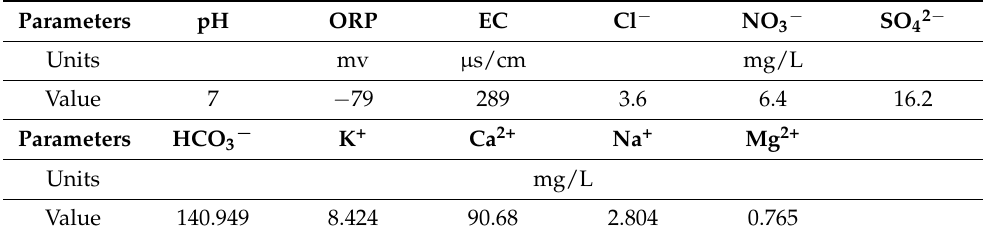
Table 1. Hydrochemical characteristic of synthesized groundwater (SGW)